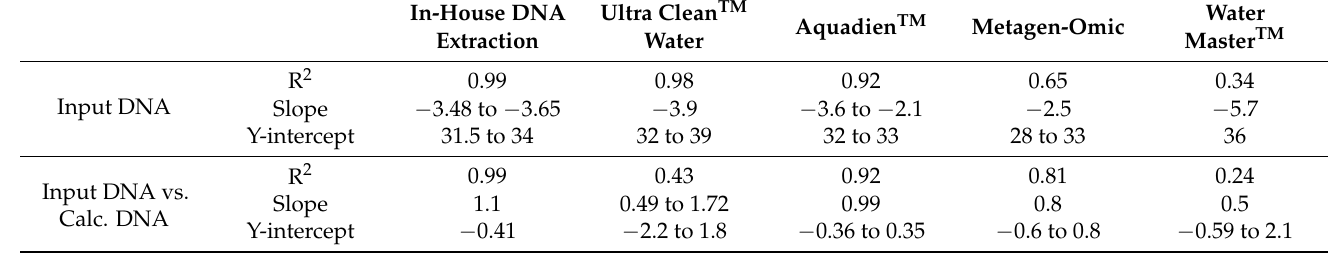
Table 3. Linear Regression summary of the in-house DNA extraction method and commercial water-testing kits.